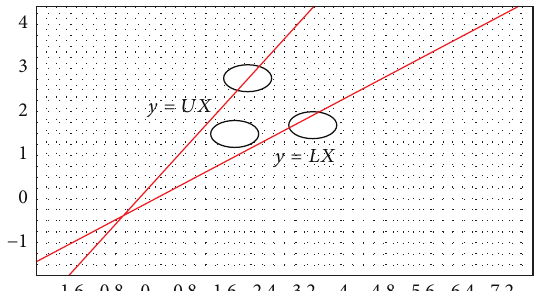
Figure 2: Biosimilarity criteria for two-parameter